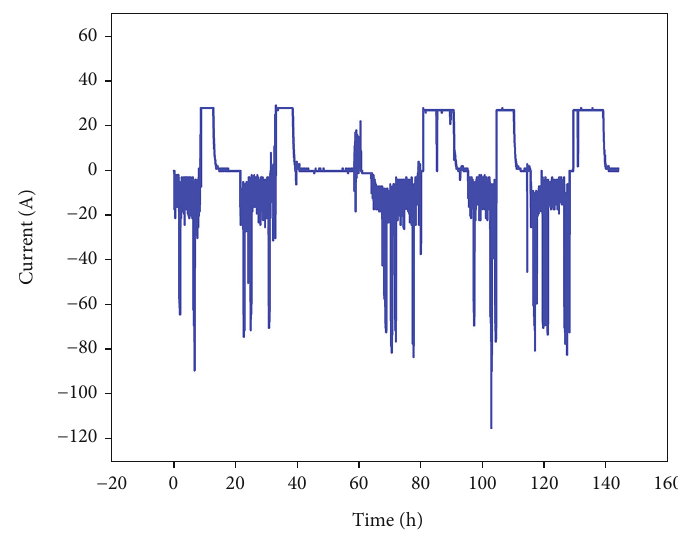
Figure 4: The current of the PV energy storage system.